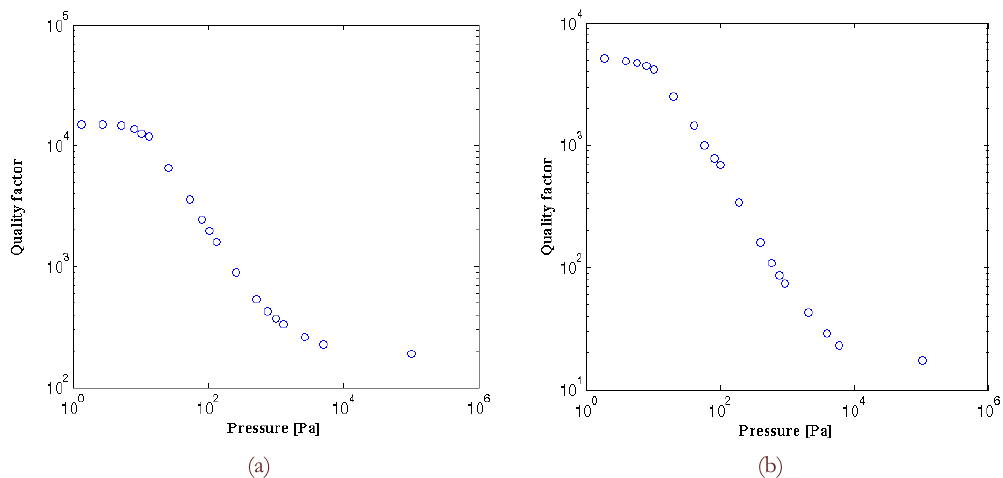
Figure 5: Values of the damping coefficient versus pressure of the torsion micromirrors 1 (a) and 2 (b) reported by Minikes et al. [17].